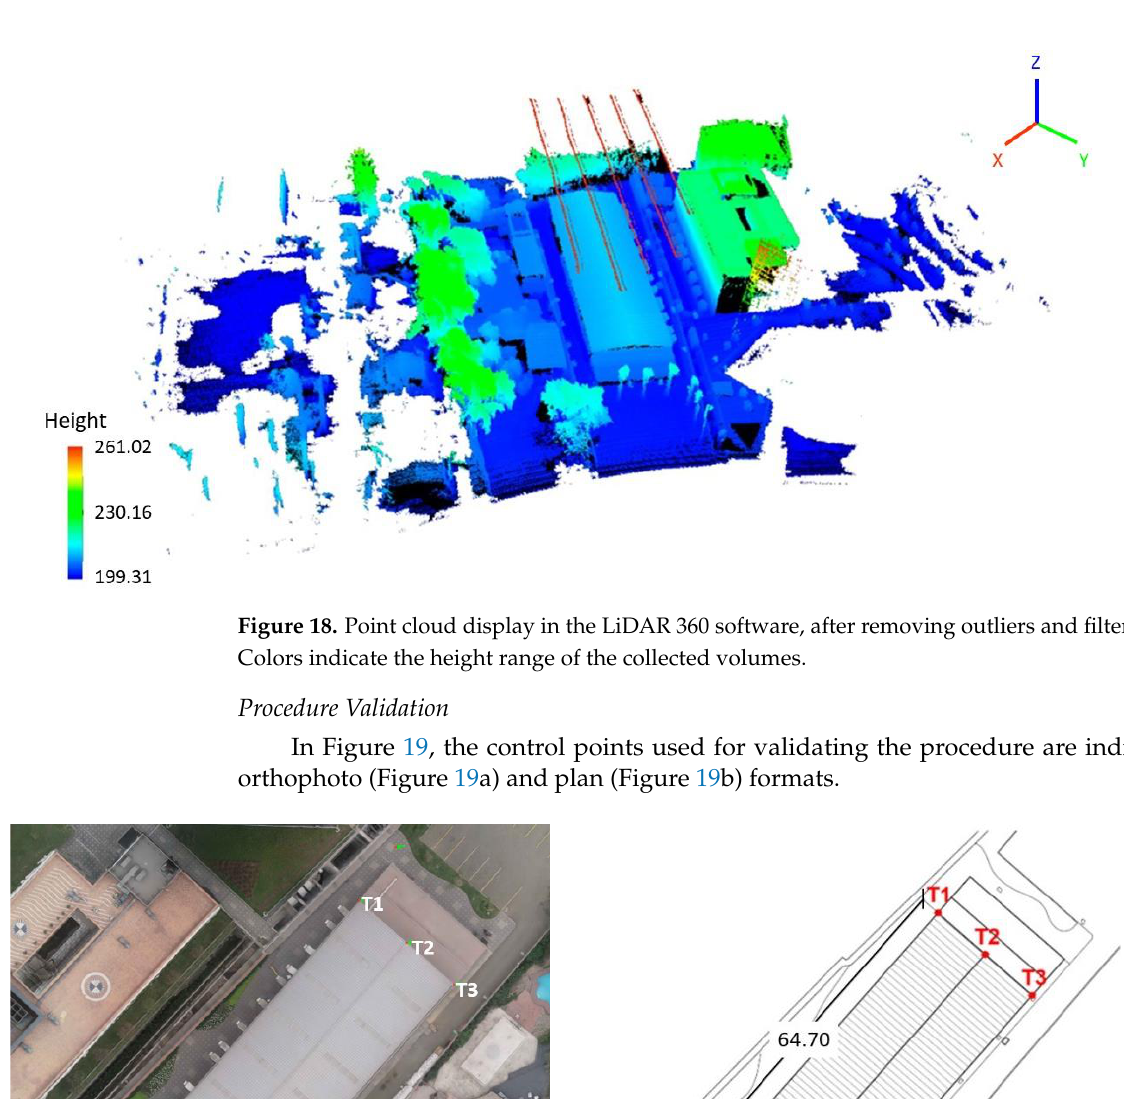
Table 6. Flight parameters.